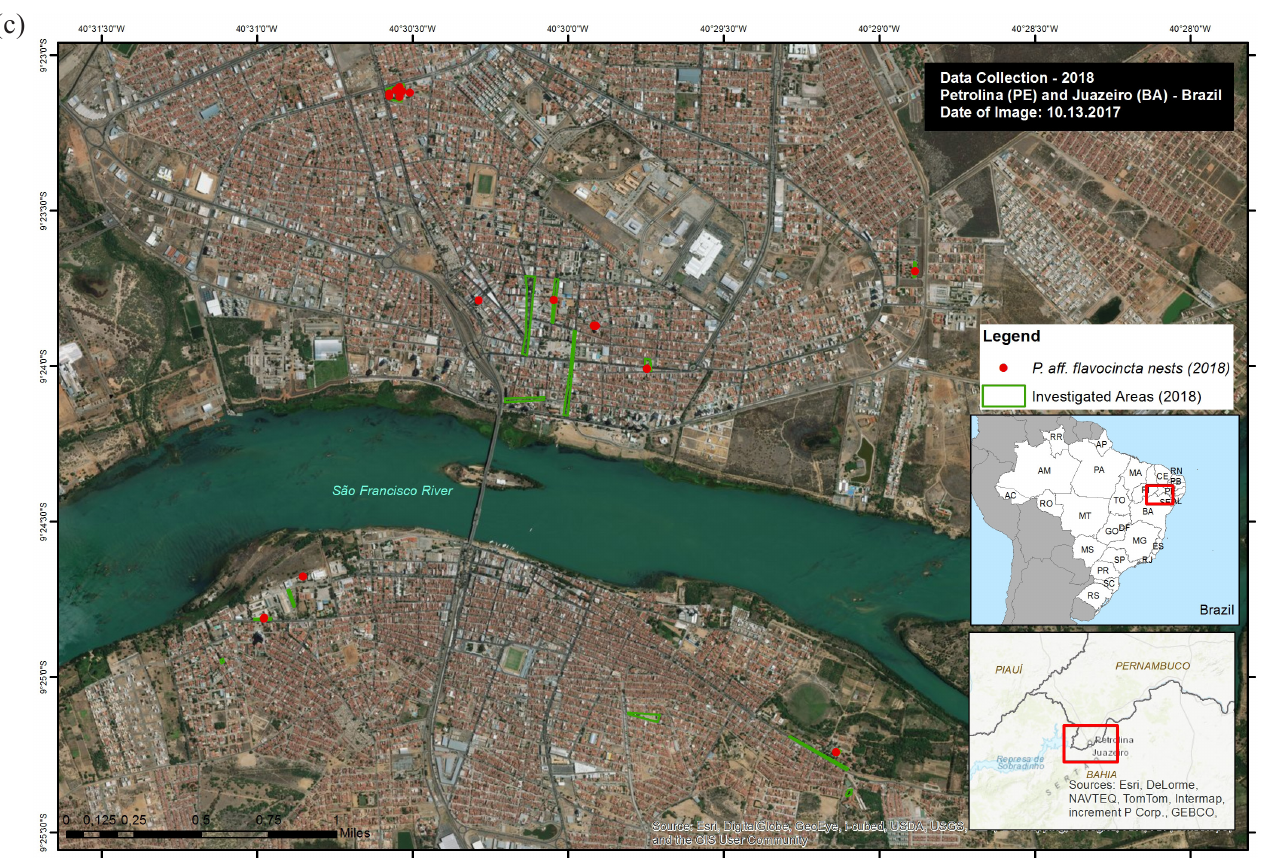
Fig 1 . Images of satellite that show GPS points where nests of Plebeia aff. flavocincta nests were sampled in Petrolina and Juazeiro, in 2009 (a), 2015 (b) and 2018 (c). Images were obtained from Google